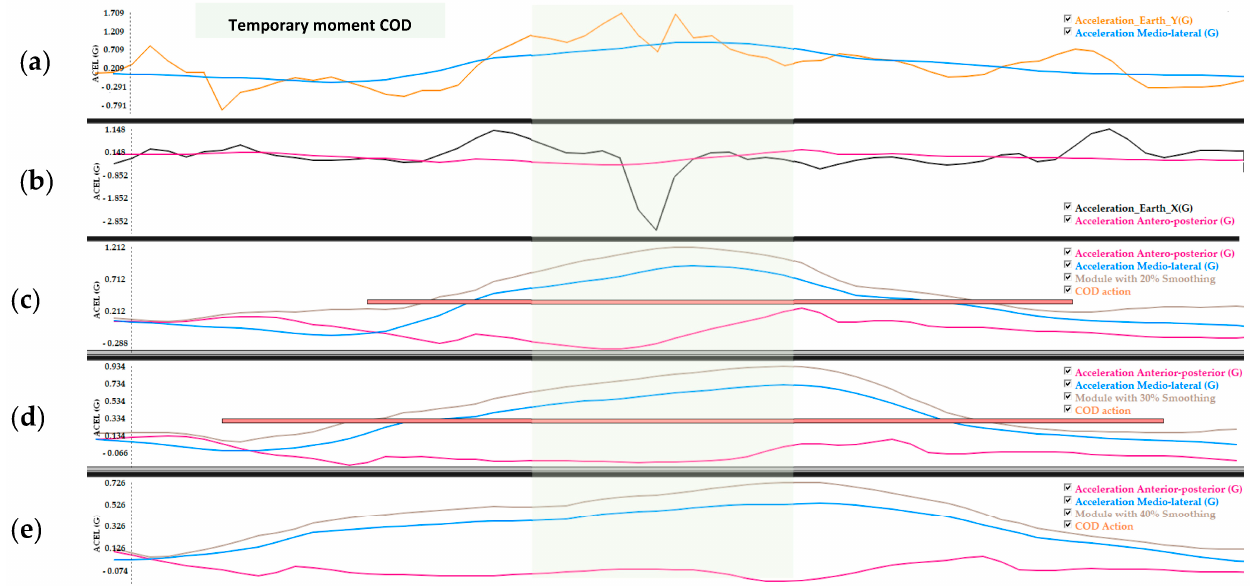
Figure 1. ( a ) Earth Y acceleration signal and its conversion to medio-lateral acceleration. ( b ) Earth X acceleration signal and its conversion to anterior-posterior acceleration. ( c – e ), represents the signals unified (module) by the algorithm at 20%, 30%, and 40% Smoothing + Minimum intensity peak (PmI) 0.8 G respectively. The orange bar indicates if the algorithm has detected COD and its duration (length of the